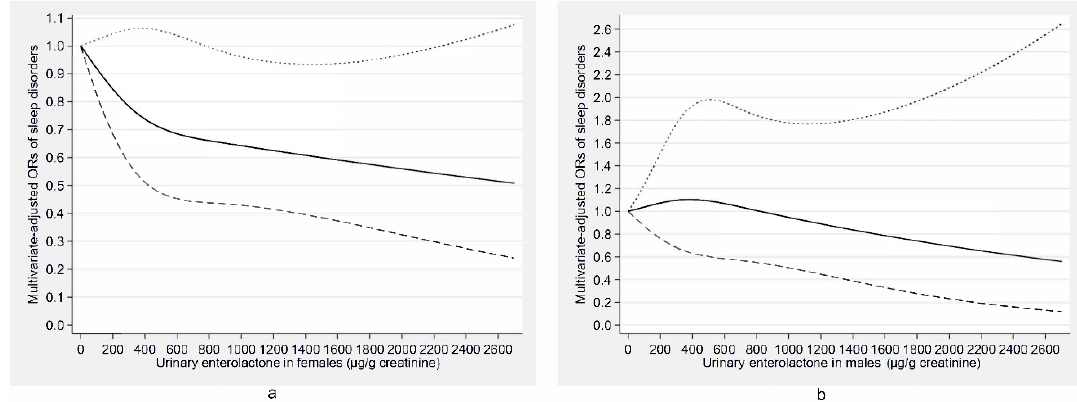
Figure 5. Concentration–response relationship of the urinary enterolactone concentration with sleep disorders for females ( a ) and males ( b ). The solid line represents the estimated odds ratios (ORs) and the dashed lines represent their 95% confidence intervals. The relationship adjusted for age, marital status, race, occupation, family income, educational level, body mass index, smoking status, alcohol consumption, use of female hormones (only in females), physical activity, caffeine intake, C-reactive protein, hypertension, depressive symptoms, diabetes, and the other five phytoestrogens (tertiles).